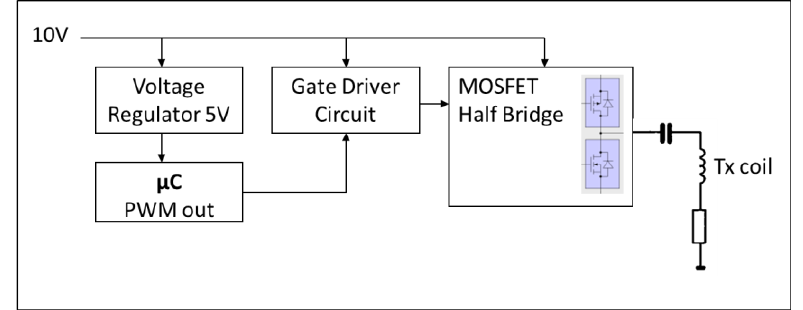
Figure 2. Bloc diagram of the driving electronics of the wireless heating